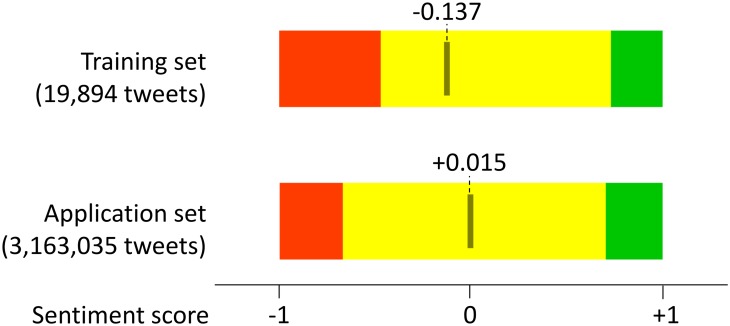
The sentiment distribution of the environmental tweets in the training and application sets.Negative tweets are denoted by red, neutral by yellow, and positive by green color. The grey bar denotes the sentiment score (the mean) of each dataset.